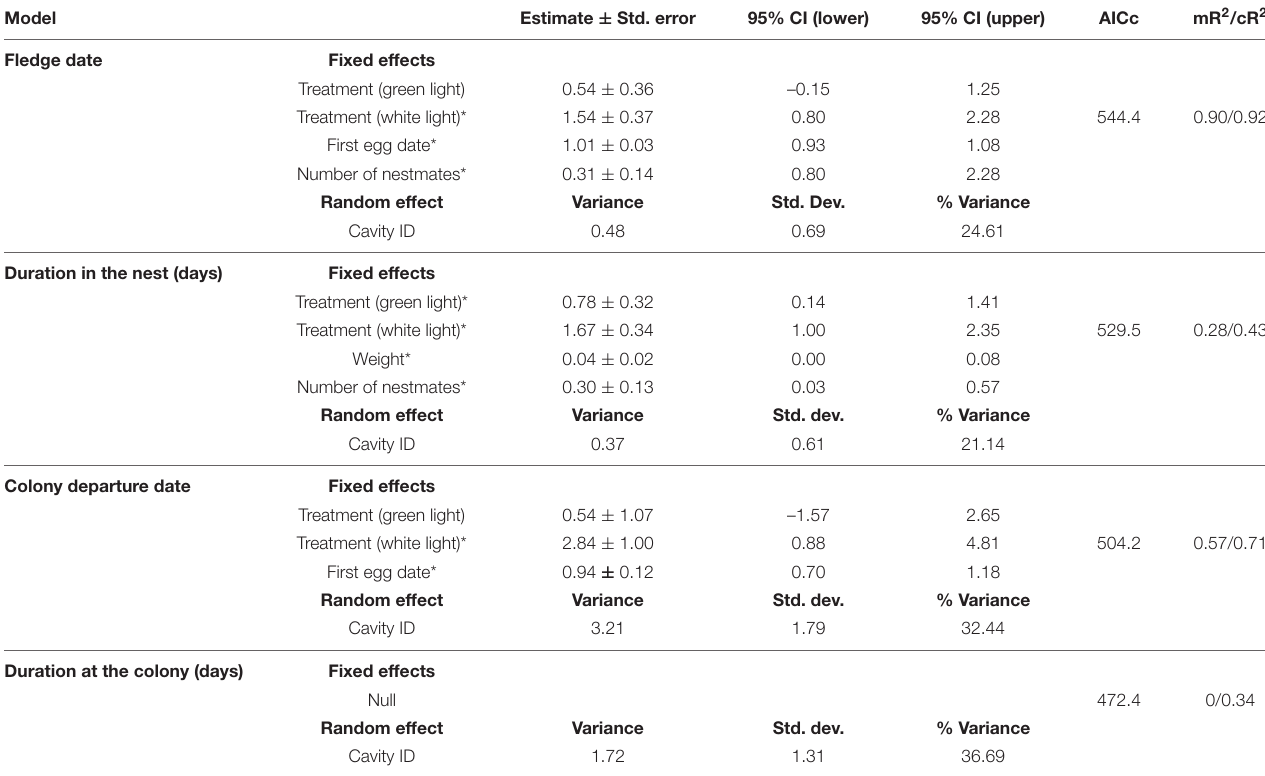
TABLE 1 | The best models of the linear mixed-effects analysis of effects of ALAN, weight, first egg date, number of nestmates on nesting period, fledge date, and effects of ALAN, first egg date, nestmate numbers on duration of staying at the colony and colony departure date.